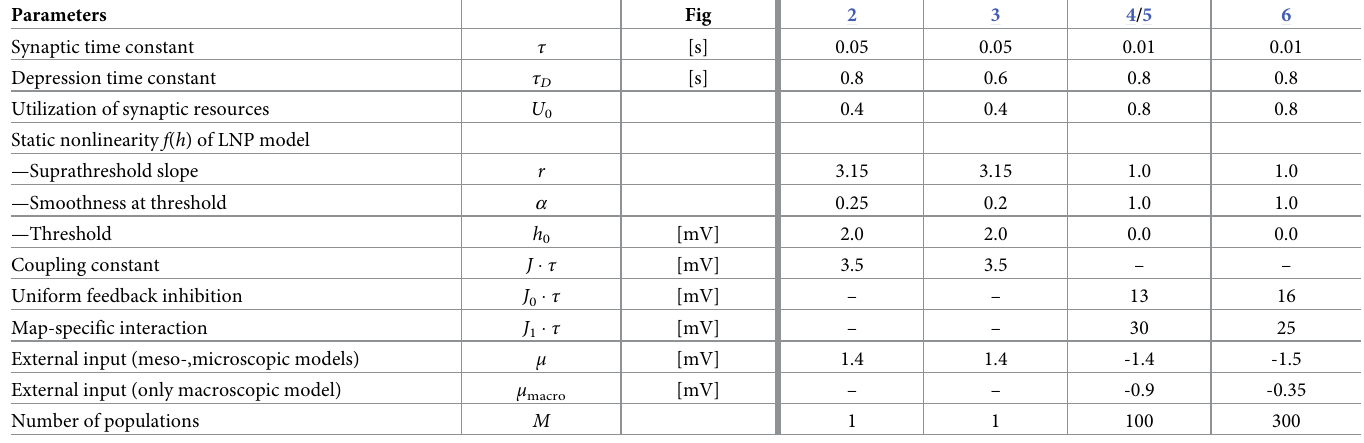
Table 1. Parameters used in Figs